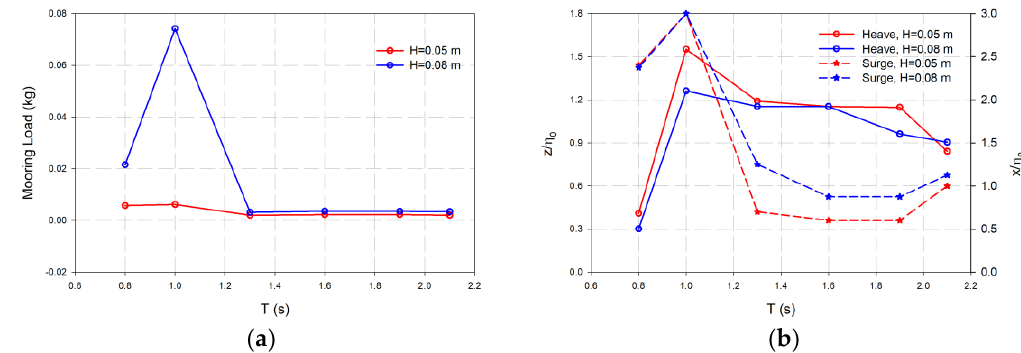
Figure 16. OWC WEC mooring line tension response for the heave and surge motions as a function of wave period ( T ), ( a ) mooring loads, ( b ) normalized surge ( x / η 0 ) and heave ( z / η 0 ) motions (OWC3: d = 0.625 m, and H = 0.05, and H= 0.08 m)